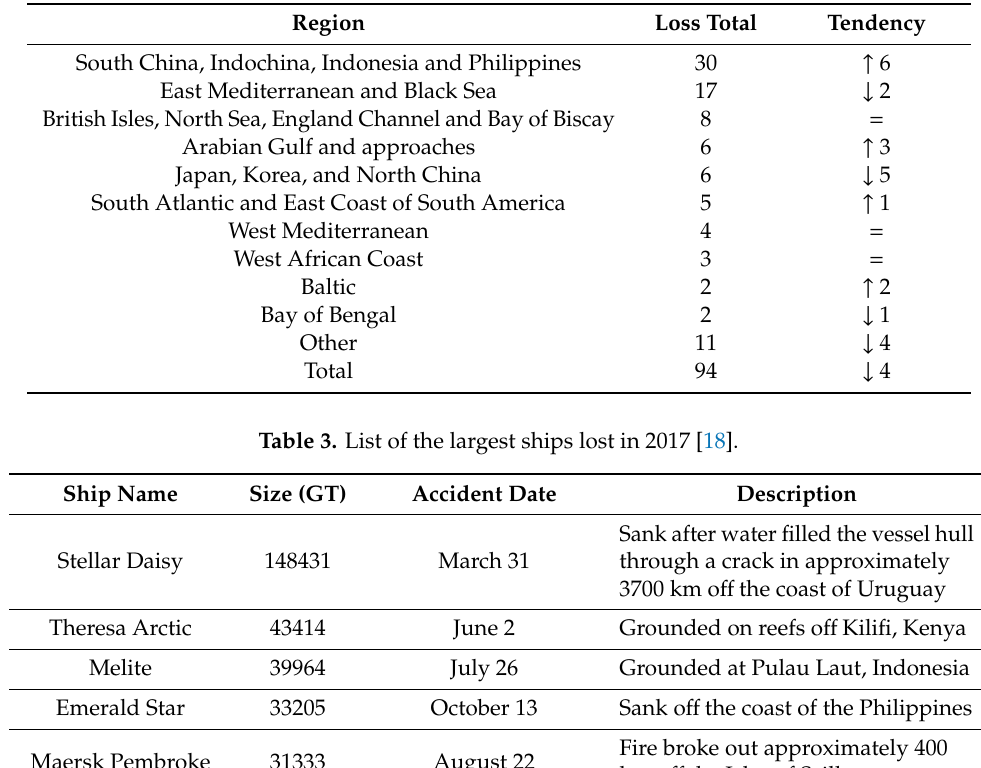
Table 2. Total losses during 2017 accounting for accident regions [18].